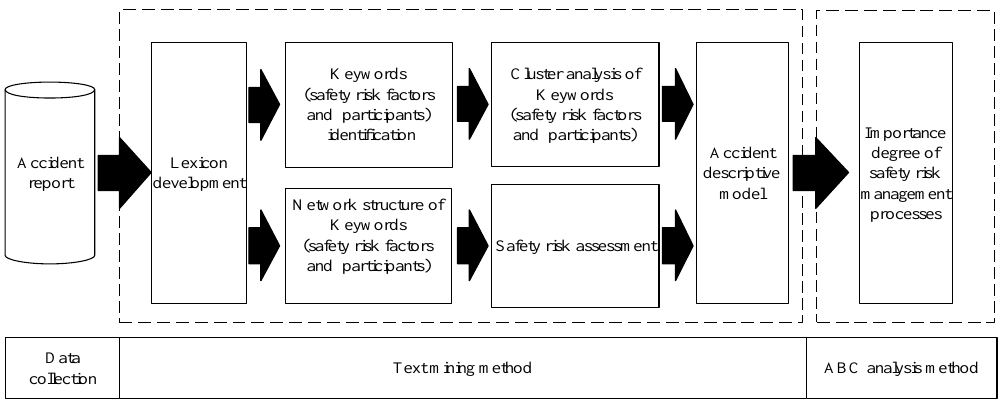
Figure 1. Research approach and methodology.